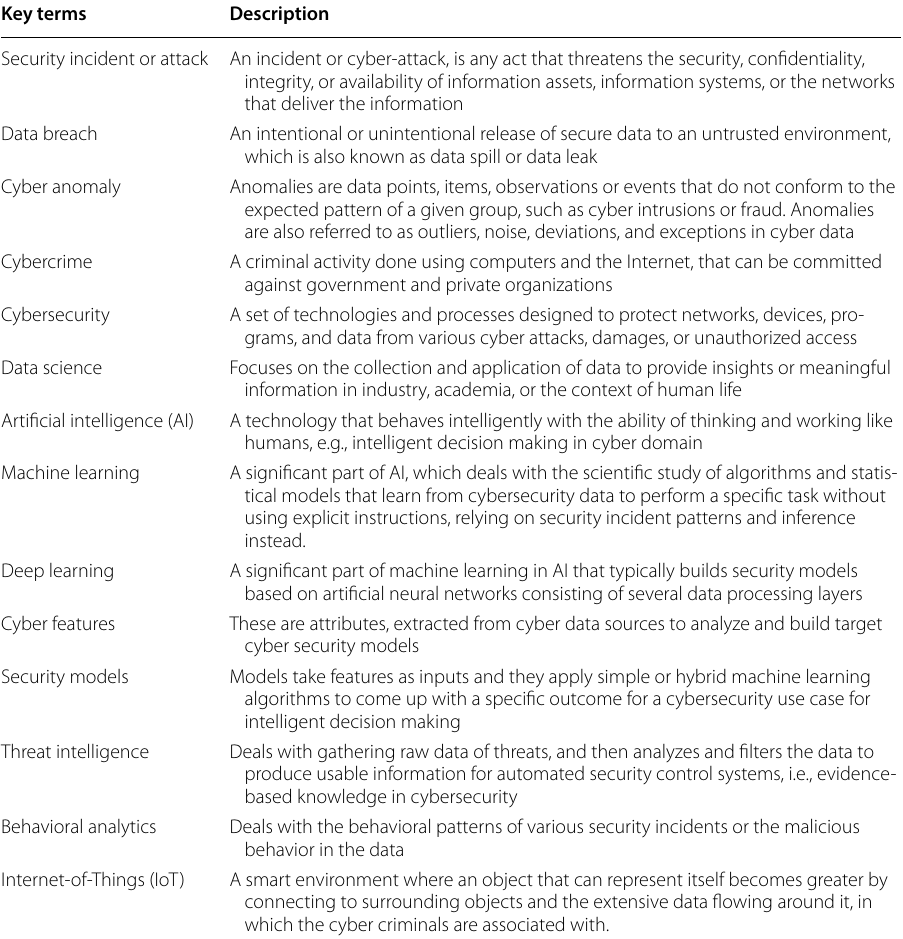
Table 3 A summary of key terms and areas related to cybersecurity data